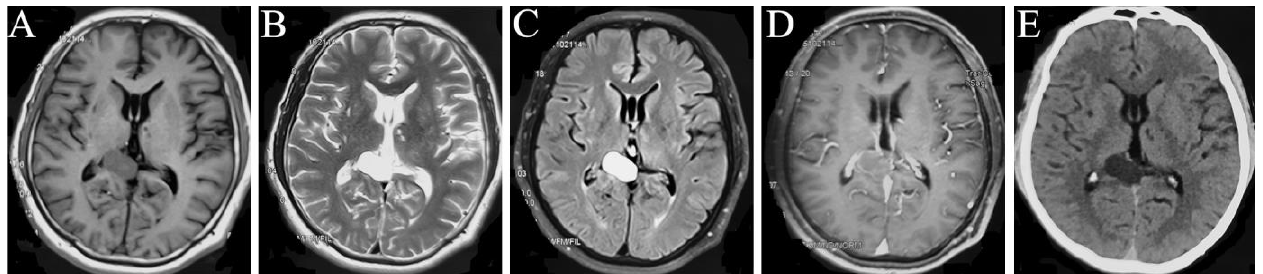
Figure 1. MRI manifestations of the space-occupying intracranial fungal lesion on 21 October 2015. T1WI ( A ), T2WI ( B ), T2 Flair ( C ), Contrast-enhanced T1 ( D ), and CT ( E ) show a right occipital lobe occupation, with regular shape and clear boundary, with equally high signals on T1WI ( A ), predominantly high signals on T2WI ( B ) and T2 Flair ( C ), equally enhanced signal on contrast-enhanced T1 ( D ), and low density on CT image ( E ).